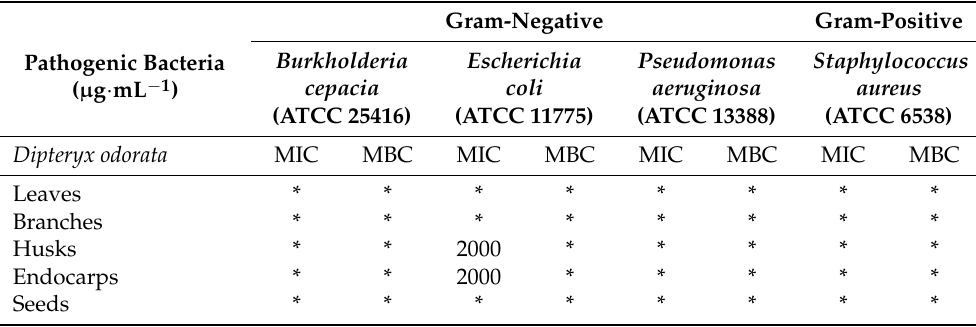
Table 6. Minimum inhibitory and minimum bactericidal concentrations of ethanolic extracts of Dipteryx odorata and Dipteryx punctata